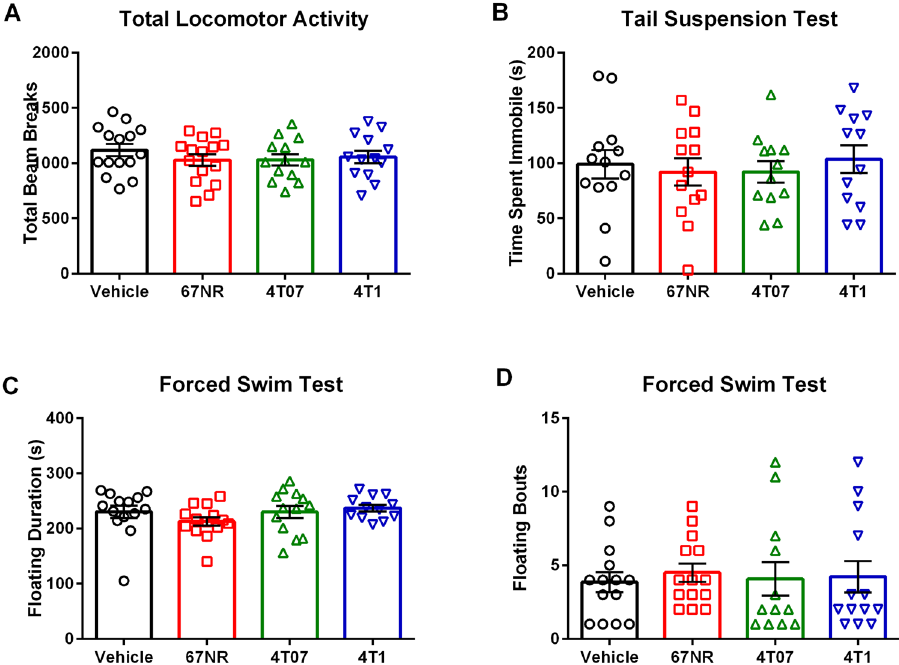
Figure 5. Locomotor Deficits or Depressive-like Behaviors are not Induced by Mammary Tumors. ( A ) Total number of beam breaks for vehicle and treatment groups during open field testing. There were no significant differences in total locomotor activity. ( B ) Immobility time during tail suspension test for vehicle and treatment groups. There were no significant differences in time spent immobile. ( C – D ) Average time spent floating and number of floating bouts for vehicle and treatment groups during forced swim test. There were no significant differences in floating duration or floating bouts. The measures and tissues were collected 20 days after tumor cell or vehicle inoculation (n = 12–15/group). The data are presented as mean + SEM. Graph bars that do not share a letter are statistically significant different at p <